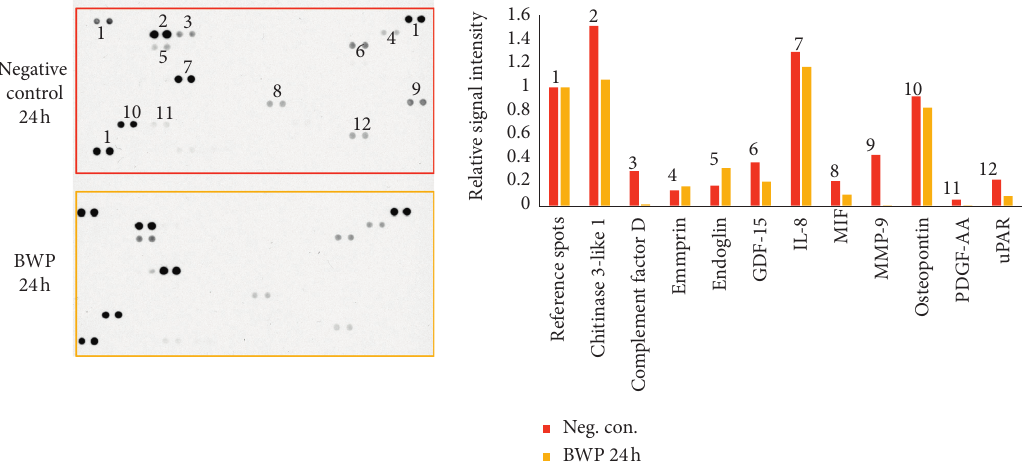
Figure 3: Cytokine array screening assay repeat results. Left: scan of a 4-minute exposed film. Right: relative intensities of positive signals. Coordinates of positive signals are identified by the numbers on the negative control array. Table 1: MMP-9 and TIMP-1 levels and corresponding ratios.